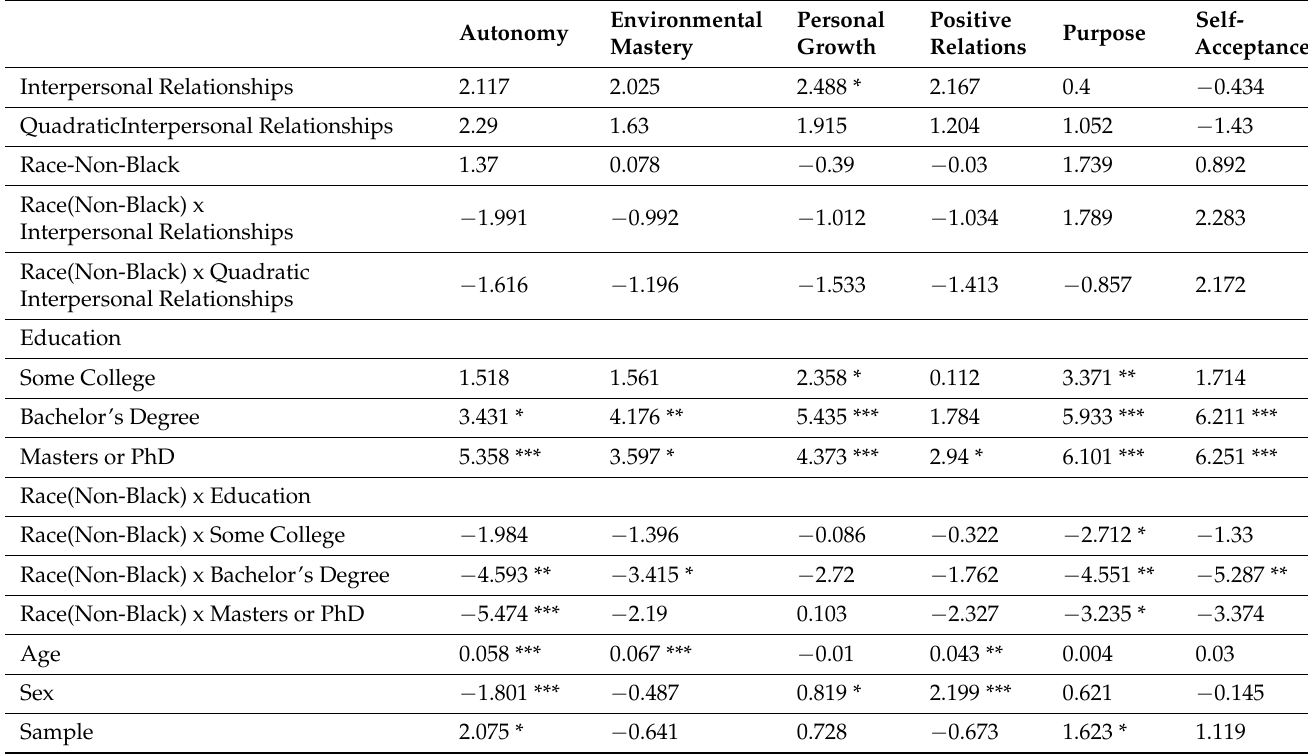
Table A7. Interpersonal Relationships and